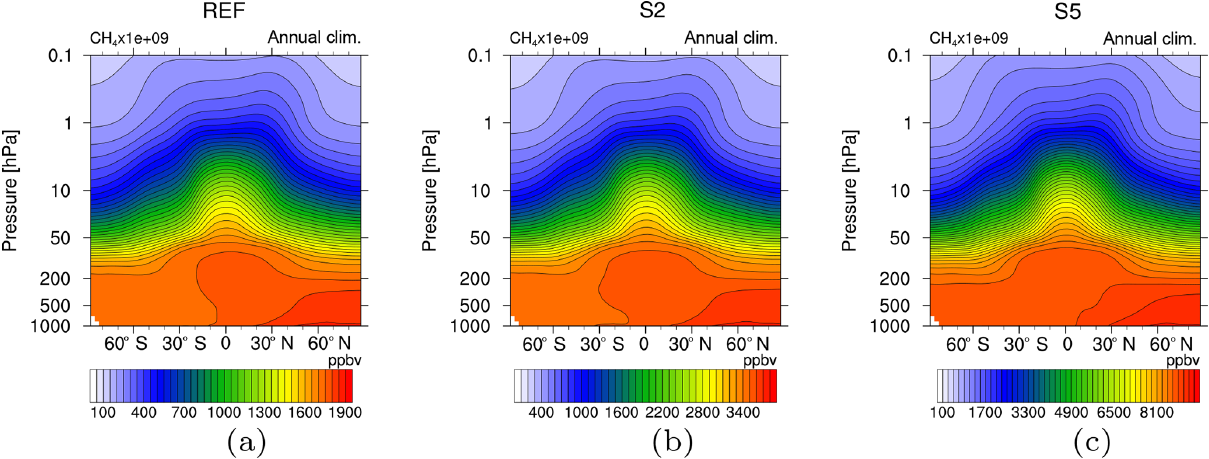
Figure 1. Annual zonal mean of absolute CH 4 mixing ratios (in parts per billion volume (ppbv) of reference (REF) (a) , S2 (b) and S5 (c) . Note the different colour